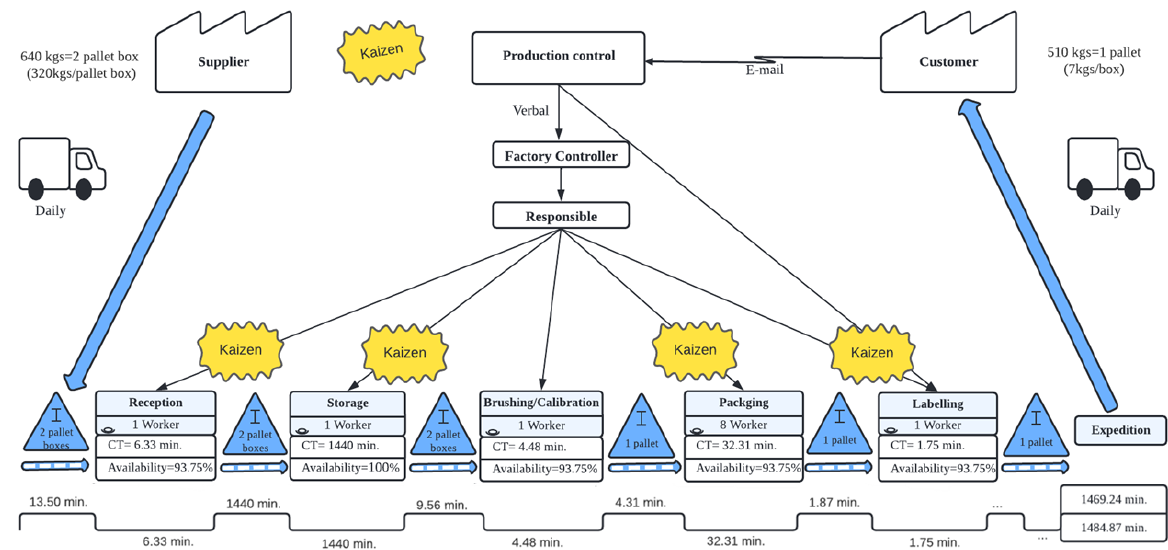
Figure 5. VSM with improvement proposal.